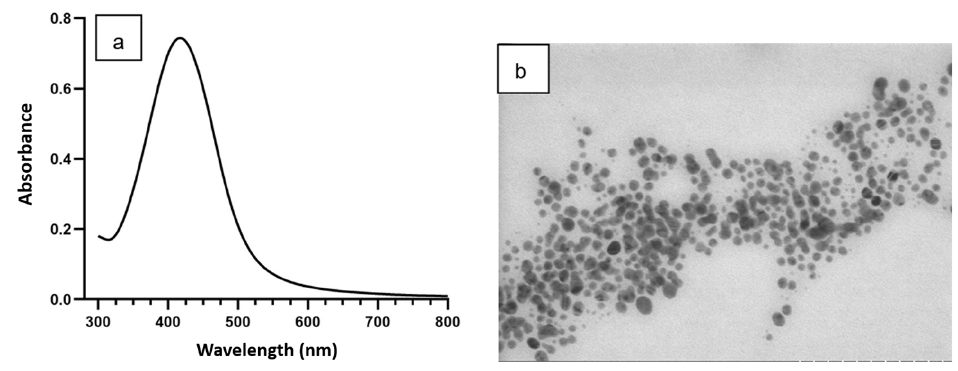
Figure 1. UV-visible spectrum ( a ) and SEM/STEM) image ( b ) of the AgNPs-CMC nanocomposite.